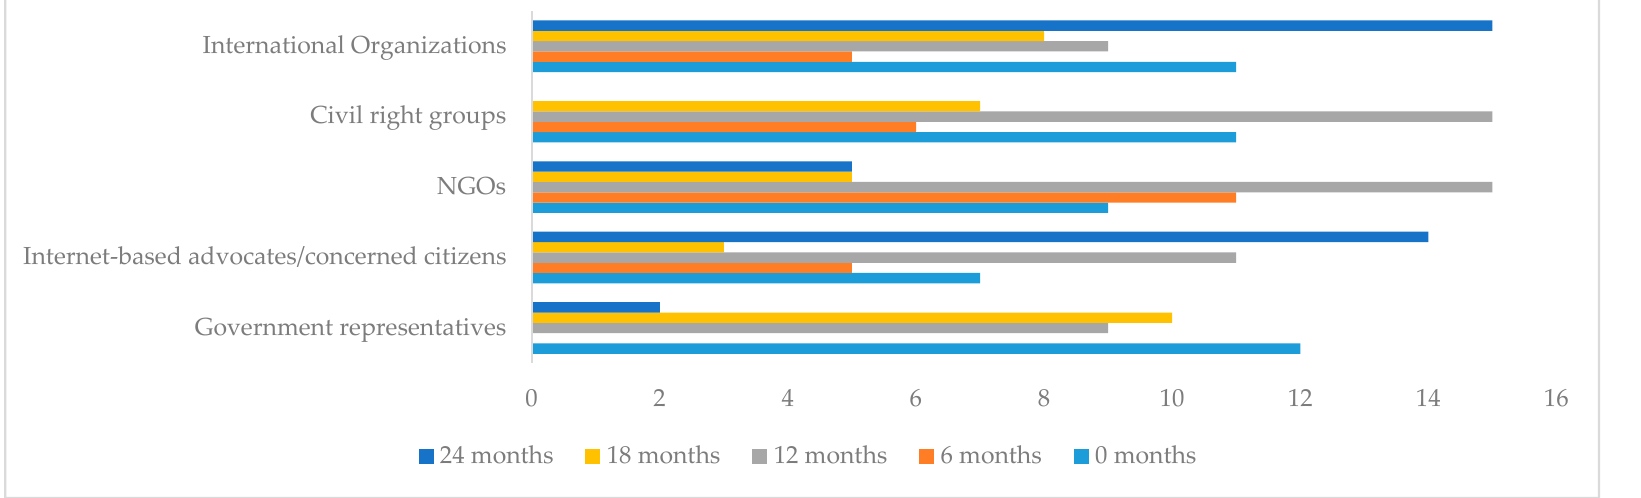
Figure A1. Distribution of respondents in Nigeria.